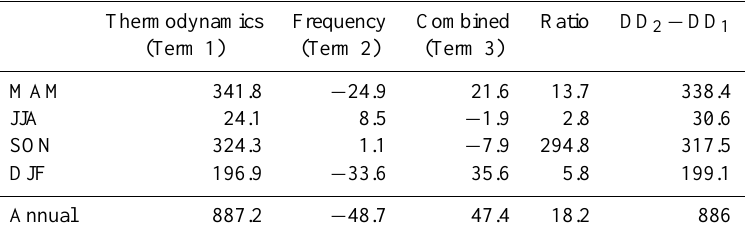
Table 1. The first three columns represent the three terms in Eq. (5). “Ratio” is the ratio of thermodynamics to frequency (that is, Term 1 divided by Term 2), DD 2 − DD 1 is the change in degree-days calculated in Eq. (5) (the sum of the three